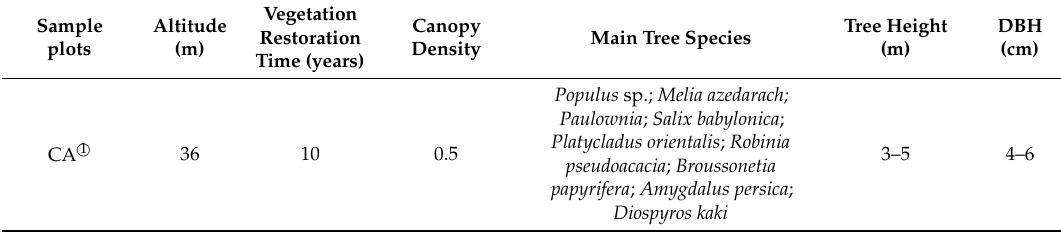
Tree Height DBH (m) (cm)